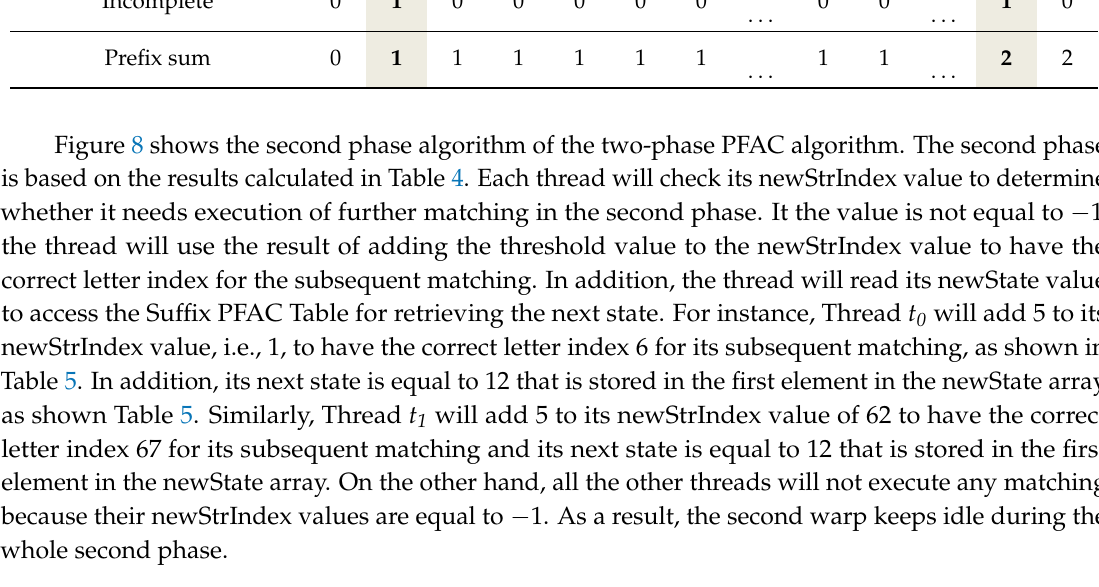
2 Table 5. The information about the job mapping in the second phase. Thread in the Second Phase